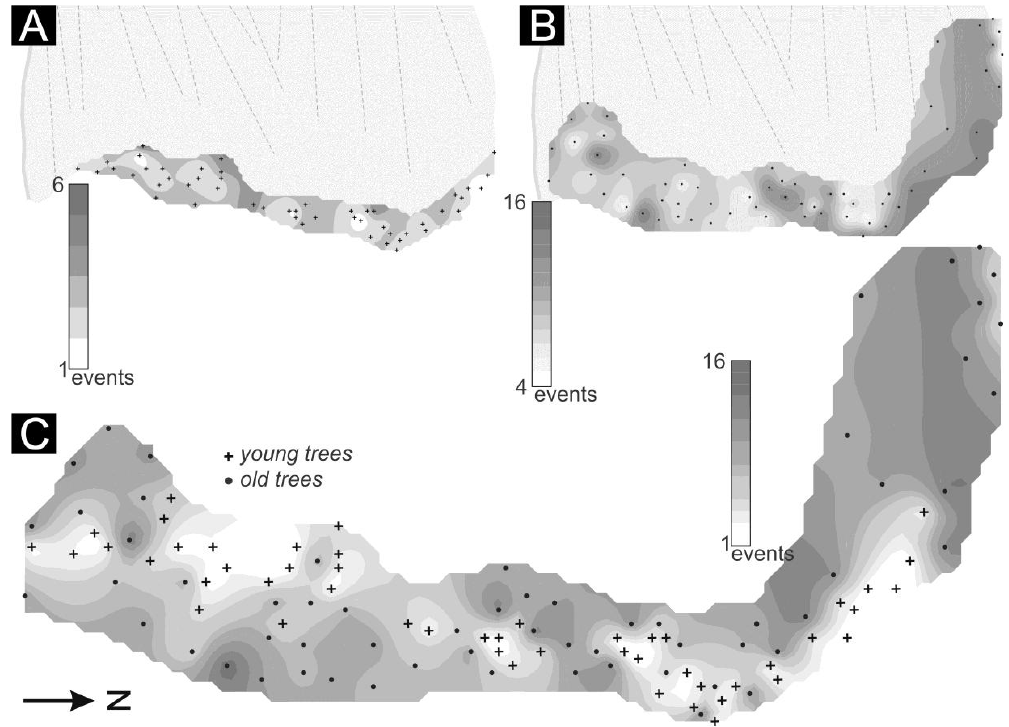
Fig. 5. Spatial distribution of rockfall events recorded within individual trees ( R n ). A – young trees, B – old trees, and C – all trees.